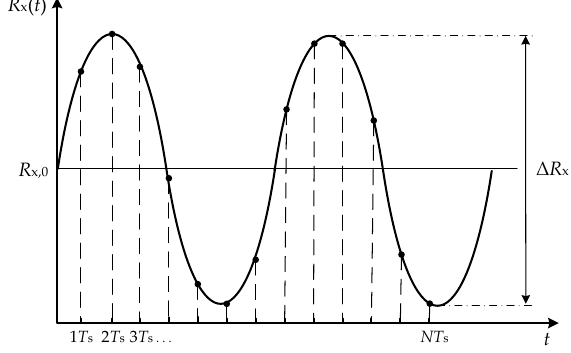
Figure 3. Dynamic signal to be measured, modulating the sensor resistance as a sinusoidal wave.